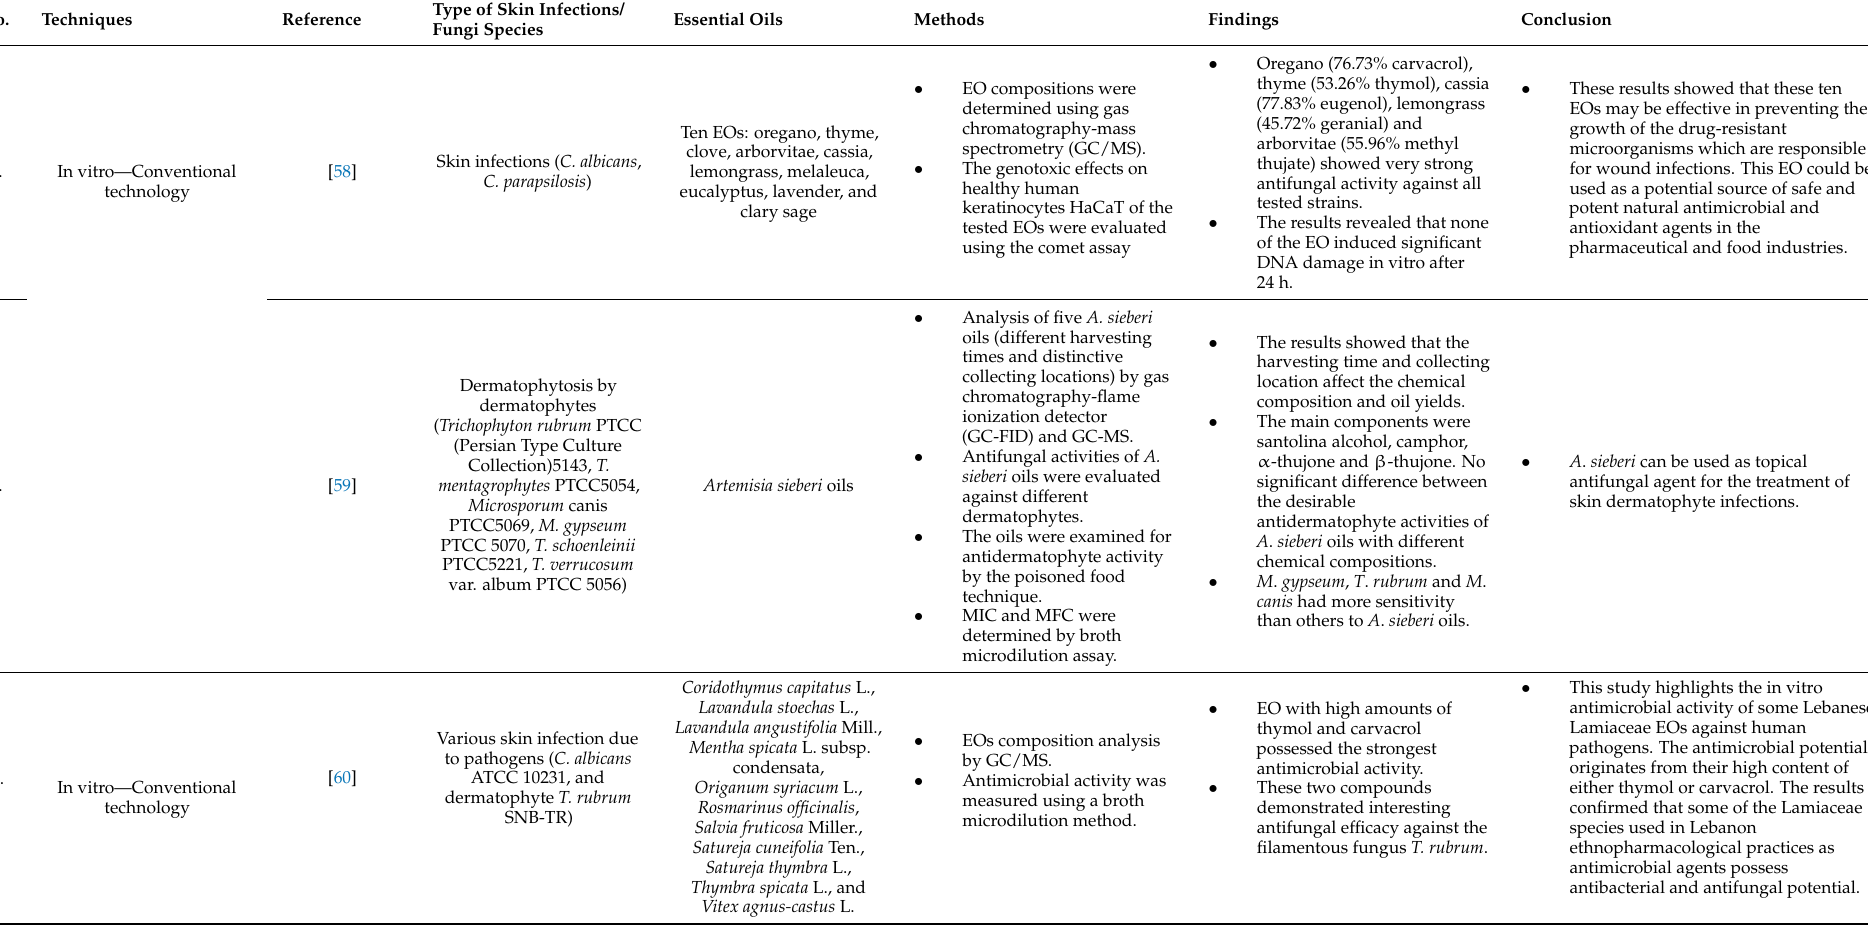
Table 1. Potential of EOs as antifungal agents in human skin